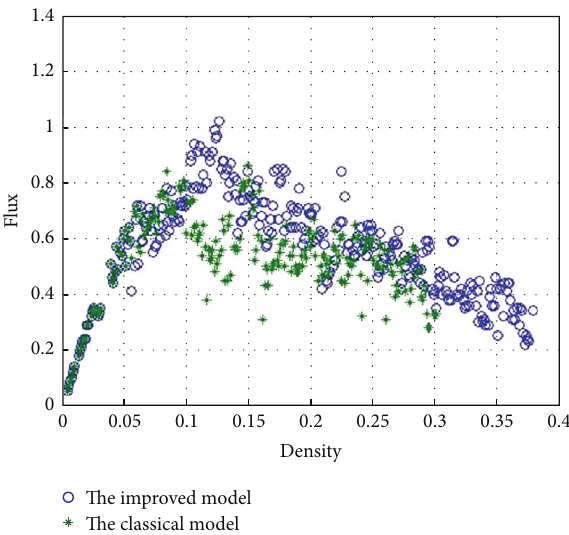
Figure 3: Flux-density diagram. “ ∘ ” is the value of proposed model; “ ∗ ” is the value of the classical model cited in [8].